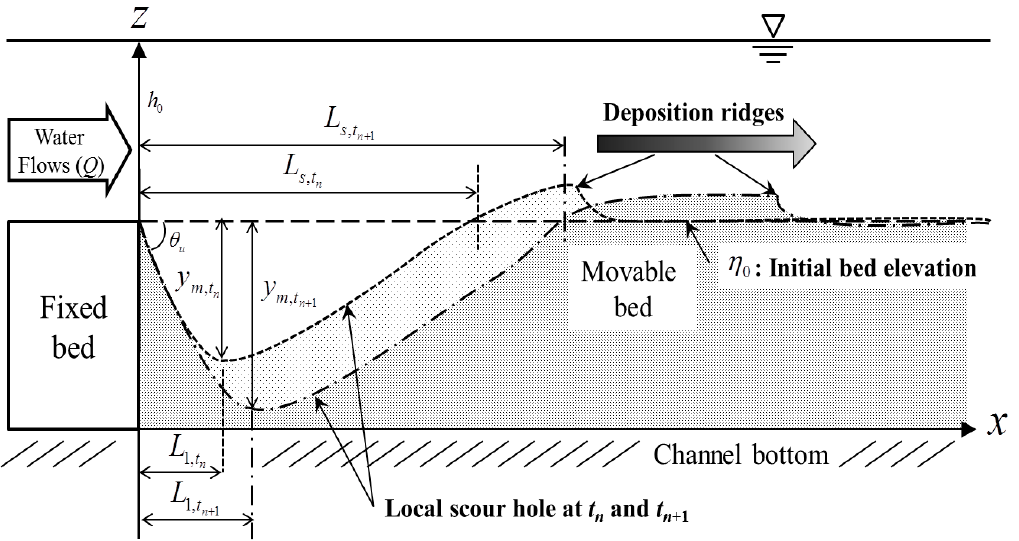
Figure 1. Schematic diagram of local scouring at the downstream of fixed bed (side view). Q is inlet discharge from the upstream of model and h 0 is water depth at the longitudinal transition. L s is the longitudinal length of scour hole and L 1 is the longitudinal distance from the transition ( x = 0) to the longitudinal location of y m at each time step. θ u denotes the upstream scour depth and η 0 denotes initial bed elevation of the model.